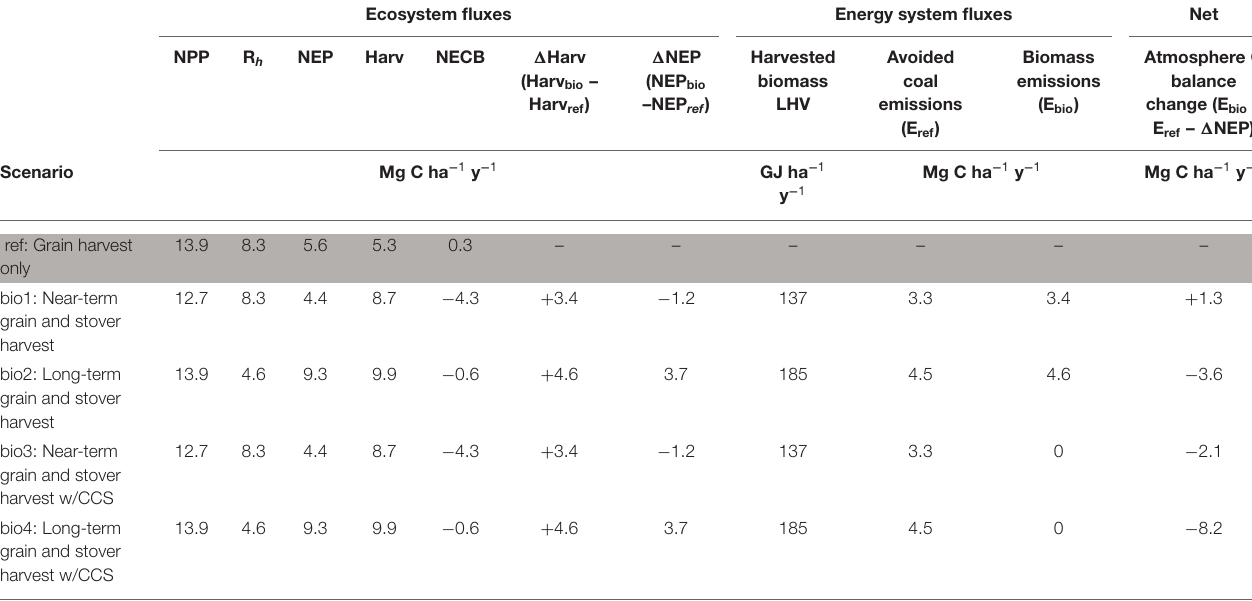
TABLE 1 | Illustrative example of changes to ecosystem–atmosphere and energy system–atmosphere carbon fluxes in response to corn stover collection for bioenergy